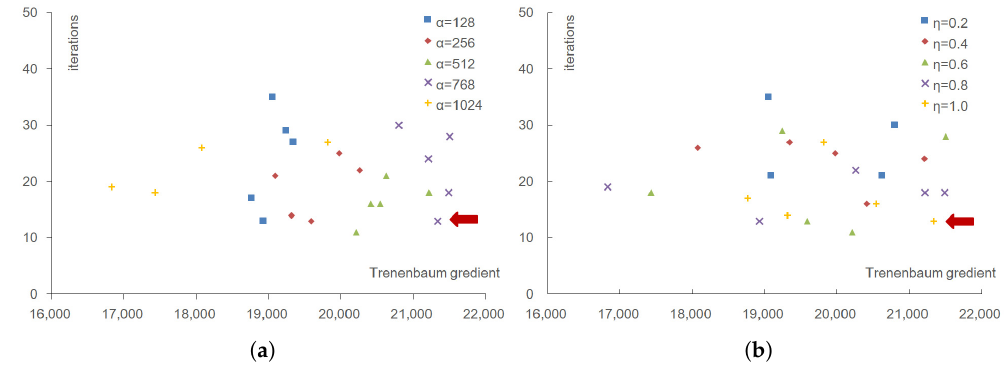
Figure 5. Relation between Tenenbaum gradient and iterations considering ( a ) initial simplex size and ( b ) convergence